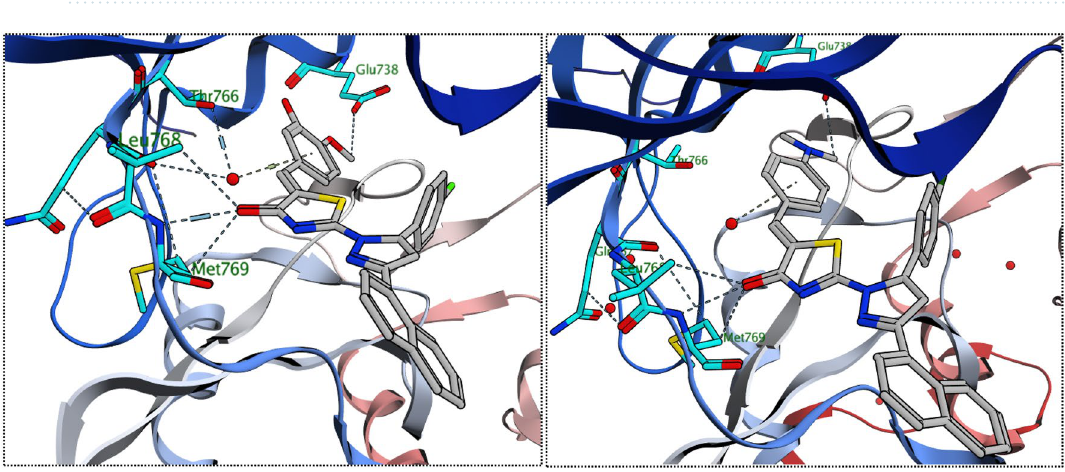
Figure 6. The 3D interaction diagram of EGFR receptor with 9g (left) 9k